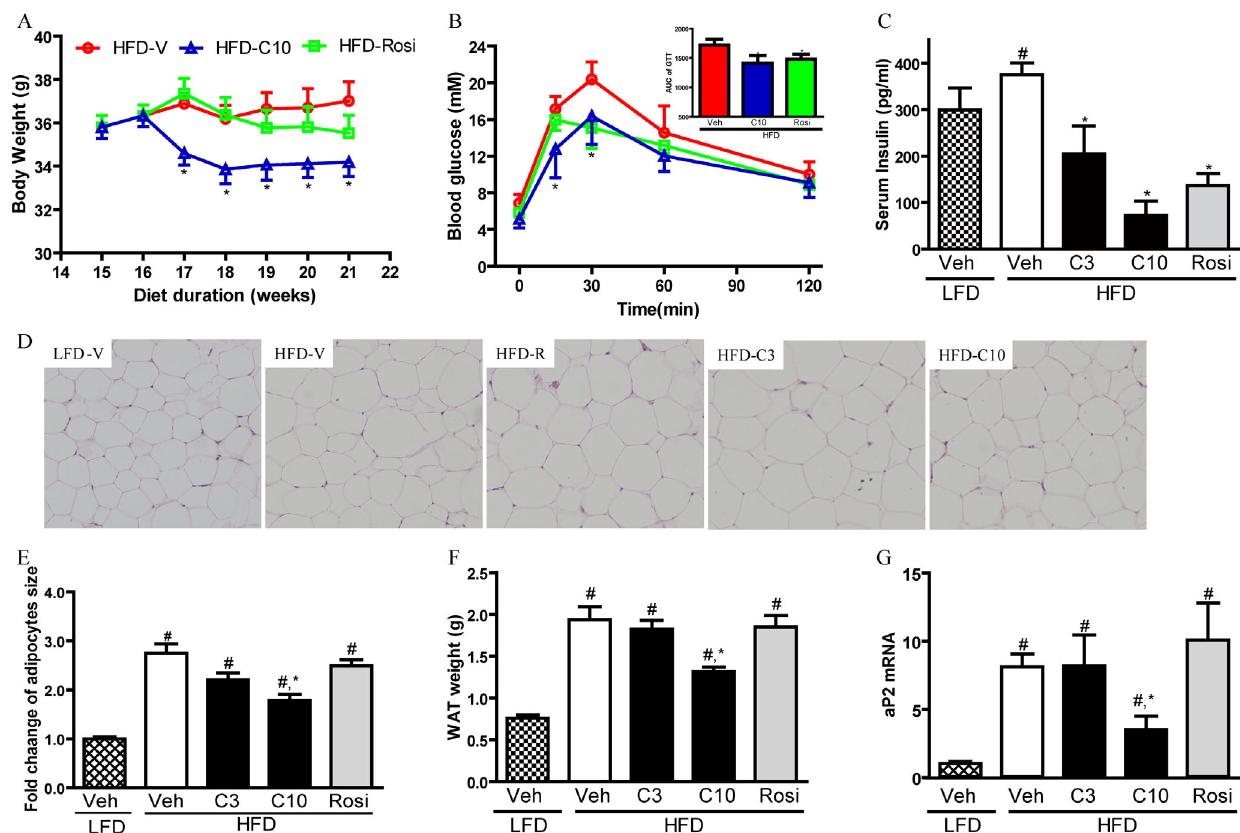
Figure 4. CMHX008 protects HFD induced obesity and insulin resistance. C57BL/6 mice were fed with HFD or LFD for 16 weeks. Then HFD fed C57BL/6 mice were treated with CMHX008 (3 and 10 mg/kg, HFD-C3 and HFD-C10), rosiglitazone (3 mg/kg, HFD-Rosi) or vehicle (HFD-Veh or LFD-Veh) only. After 4 weeks treatment, intra-peritoneal glucose tolerance tests (iGTTs) were performed (B) and area under curve (AUC) of iGTTs was calculated (B, inserted Figure). Changes in body weight (A), fasting insulin levels (C), morphology of adipocytes (D), quantified adipocyte size (E), mass of epididymal adipose tissues (WAT, F) and aP2 mRNA levels (G) were examined. Data are the means 6 S.E.M., n=6–8; # P , 0.05 vs LFD-Veh and * P , 0.05 vs HFD-Veh.